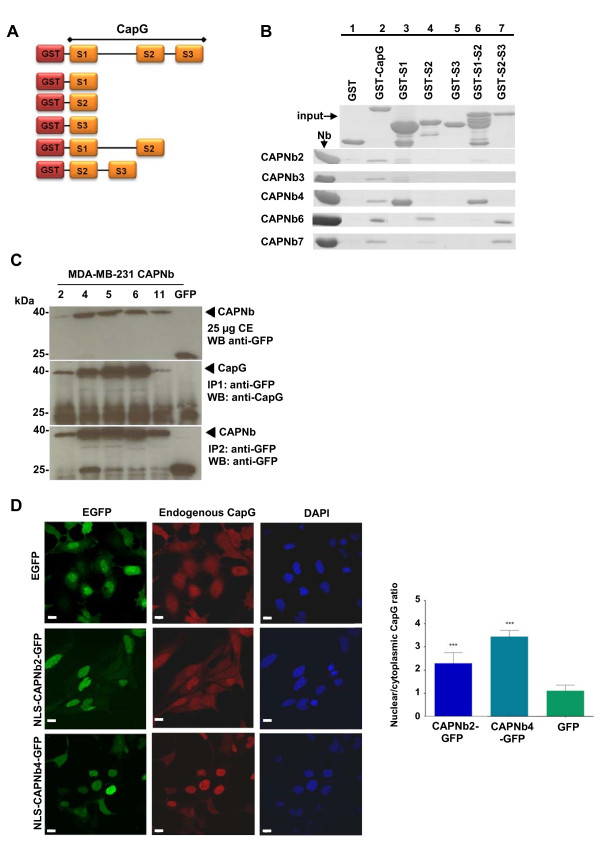
Epitope mapping and nanobody functionality as intrabody. (A) Schematic representation of GST-fusion proteins used in pull-down experiments. (B) Epitope mapping. Glutathione-S-transferase pull-down assays with recombinant CAPNbs (left, input) and GST-CapG fragments (indicated on top) were evaluated with SDS-PAGE and coomassie staining. (C) Co-immunoprecipitation. EGFP-tagged CAPNbs or a GFP control (numbers indicated on top) were stably expressed in MDA-MB-231 cells and detected in cell extracts (top panel). They were retrieved from cell extracts with a polyclonal anti-EGFP antibody (bottom panel). All CAPNbs immunoprecipitated endogenous CapG (middle panel). CE, crude extract. (D) Upper panels: MDA-MB-231 cells were transfected with EGFP (control) and stained for endogenous CapG (red) and show the typical nucleocytoplasmic distribution of CapG. Middle panels: MDA-MB-231 cells were transfected with CAPNb2-EGFP coupled to the SV40 large T-antigen nuclear-localization sequence (NLS), promoting a stronger CapG enrichment in the nucleus. Lower panels: MDA-MB-231 cells were transfected with CAPNb4-EGFP coupled to the SV40 large T-antigen NLS, redirecting endogenous CapG (red) nearly completely to the nucleus. DAPI staining of the nucleus is shown in blue at right. Bar, 10 μm. Quantification of this experiment is shown in the histogram at right. The nuclear enrichment of CapG was evaluated by determining the ratio of cytoplasmic versus nuclear CapG. Statistics were performed on 50 cells per condition, with the EGFP (control) condition as reference (***P < 0.001).